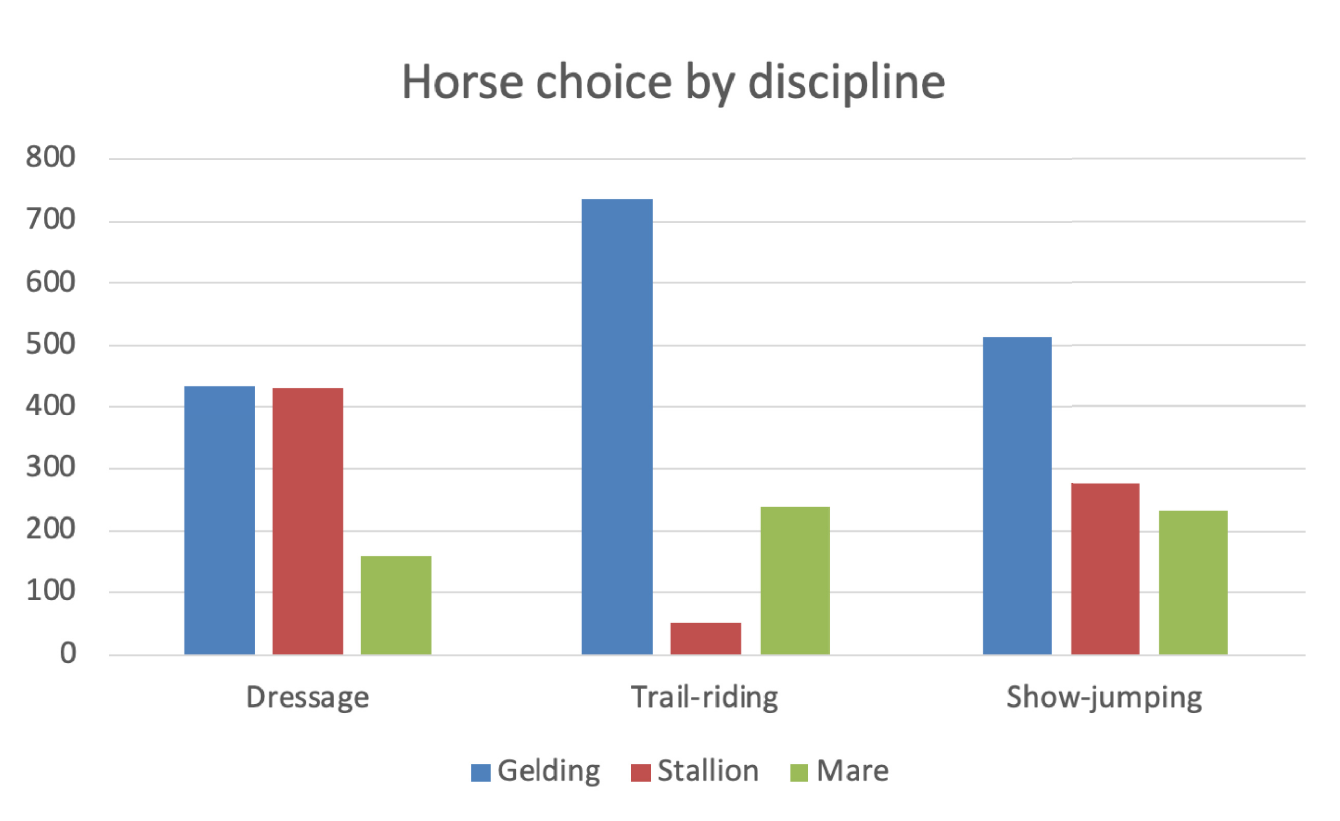
Fig 5. Horse choice by discipline. Respondents (n = 1230) were asked whether they were more likely to see a gelding, stallion or mare competing in Dressage and show- jumping and which sex of horse they would choose for trail-riding. Geldings were preferred over mares across all disciplines.